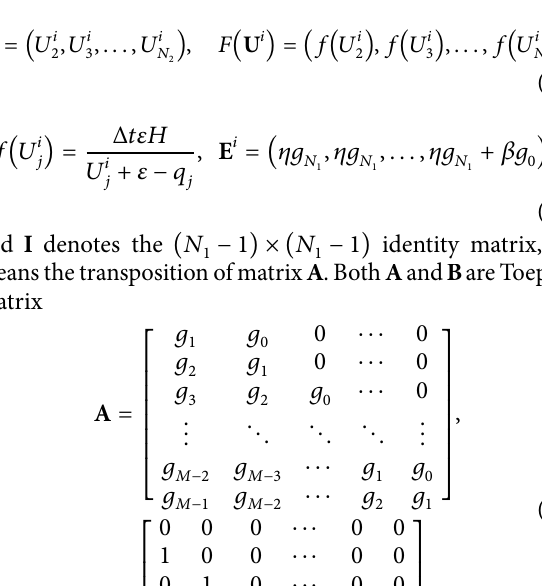
vs payoff 𝑈(𝑧,𝑡)